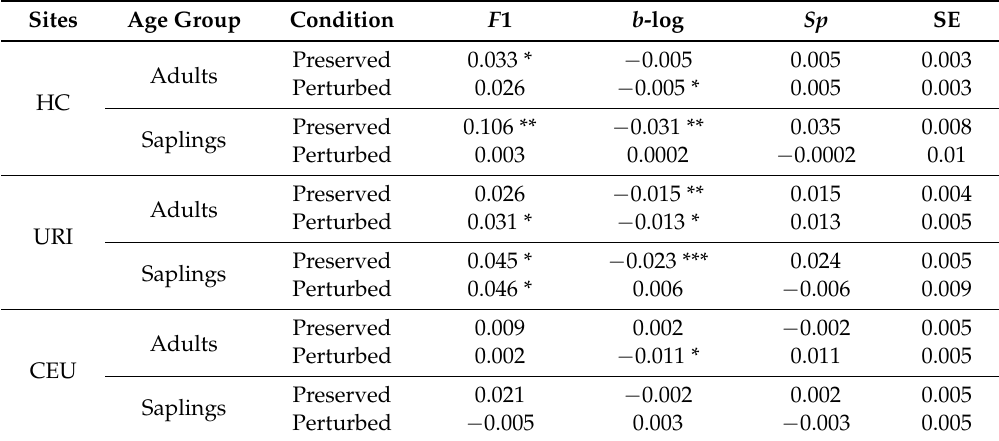
Table 3. Spatial genetic structure parameters within populations.